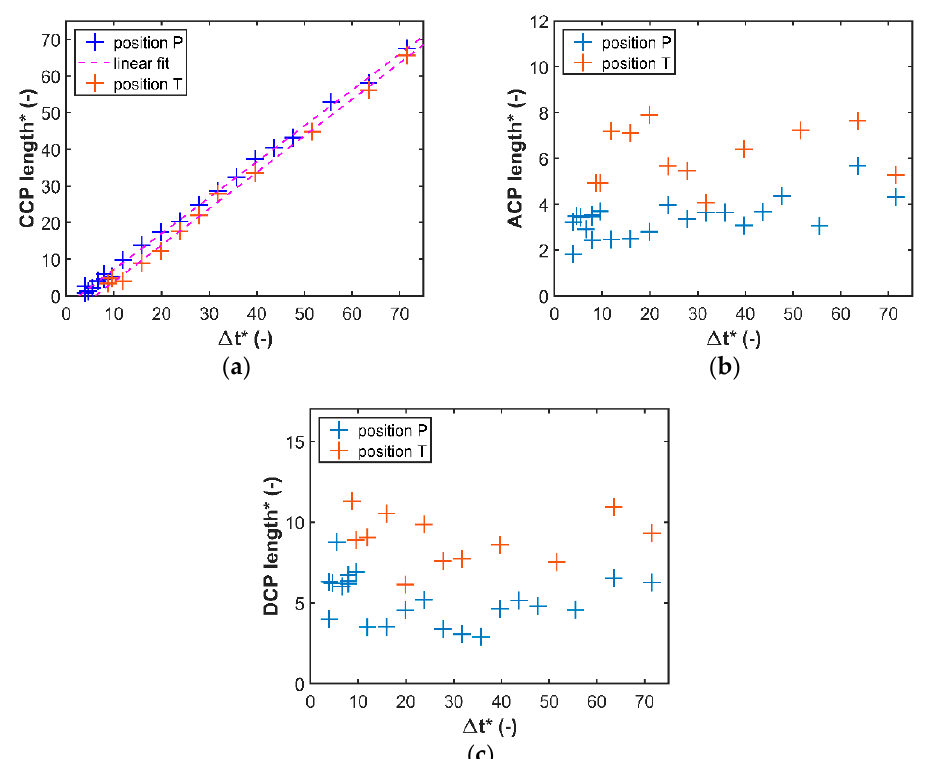
Figure 5. The length of the cloud phases: ( a ) the central cloud phase (CCP); ( b ) the arrival cloud phase (ACP); ( c ) the departure cloud phase (DCP).